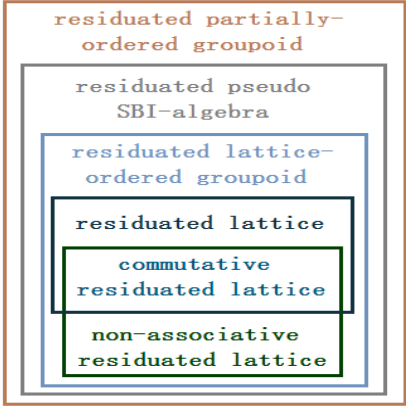
Figure 4. The relationships among some residuated algebraic